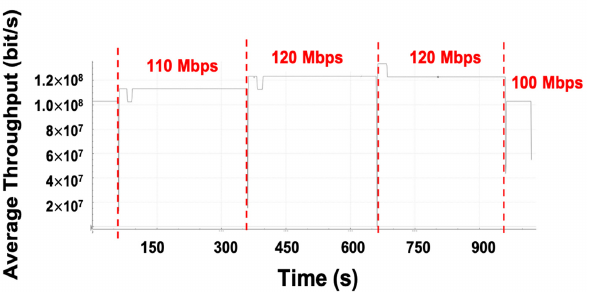
Figure 9. Real-time evolution of the allocated bandwidth for the residential user with the basic flexible Internet plan. For the Premium Internet Plan, we consider a residential user that contracts an Inter- net service, which consists of a basic symmetric service of 150 Mbps plus an excess band- width of 30% (in that case 45 Mbps or more). However, in that case, the transmission rate of the residential user starts at 150 Mbps for 60 s and after that, it is increased in five min intervals (300 s). It has been considered that in each interval the bandwidth demand is increased by 20 Mbps, so that the evolution of the demanded bandwidth in the different period times is 150, 170, 190, 210, and finally 150 Mbps again. All these levels are reflected in Table 3, which represents the demanded bandwidth by the user in the different time intervals and the expected bandwidth that will be received according to the algorithm’s performance.